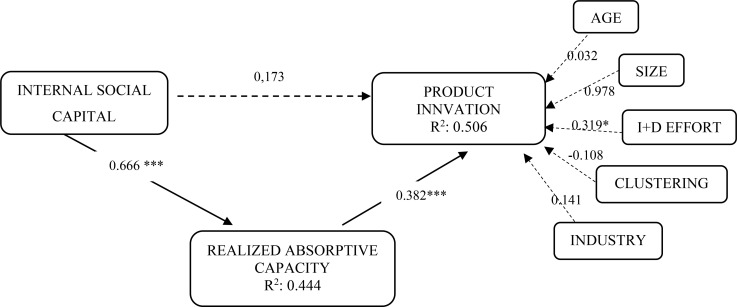
Research model and results. *p < 0.05 (t(0.05; 4999) = 1.6479); ***p < 0.001 (t(0.001; 4999) = 3.1066).